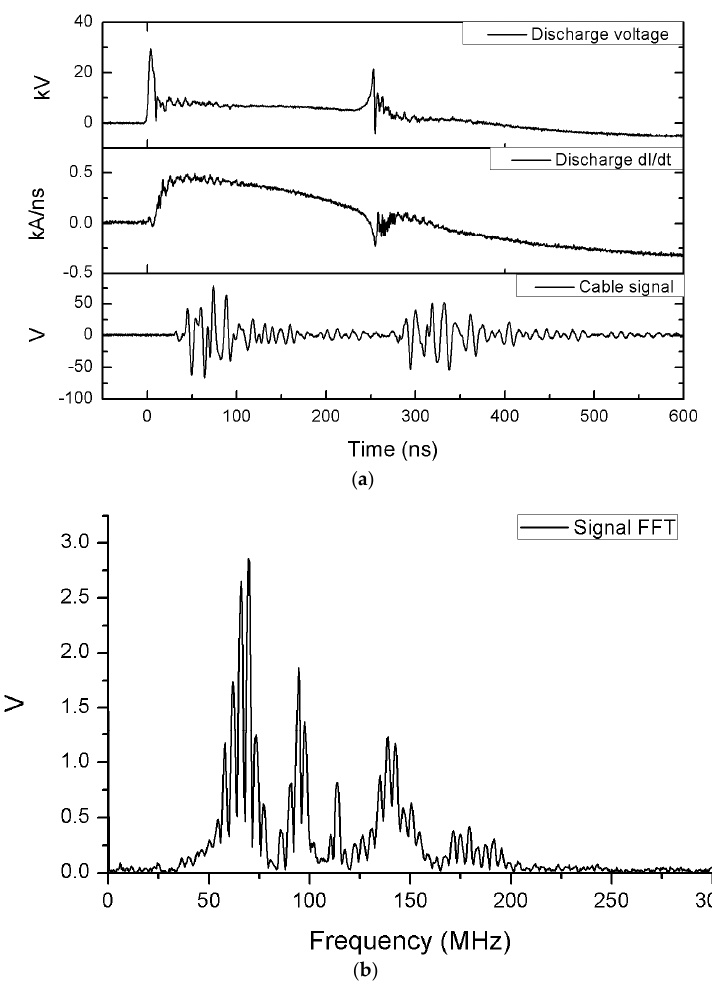
Figure 8. Time evolution of the signals in the discharge for the cable coupling measurements; ( a ) Signals from the PF-400J voltage divider ( top ), PF-400J Rogowski coil ( middle ) and cable connected to the oscilloscope ( bottom ); ( b ) FFT of the signal couple to the cable.